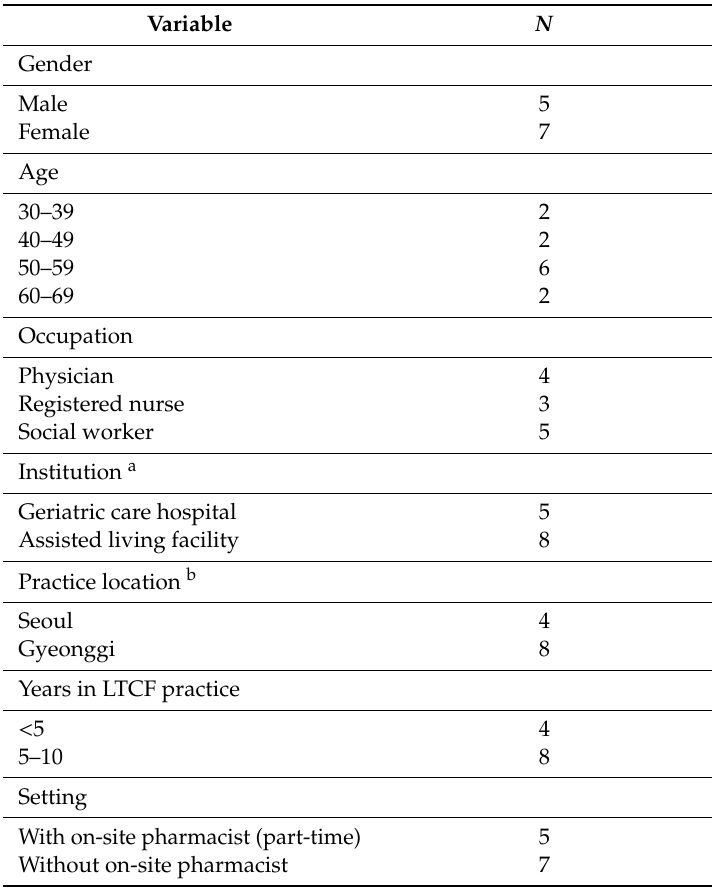
Table 2. Background information of